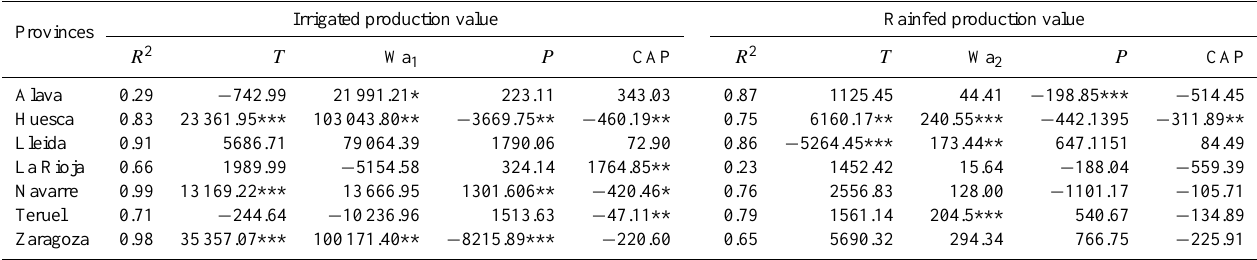
Table 2. Regression results from Direct Attribution models. Correlation coefficients and significance of explanatory variables.